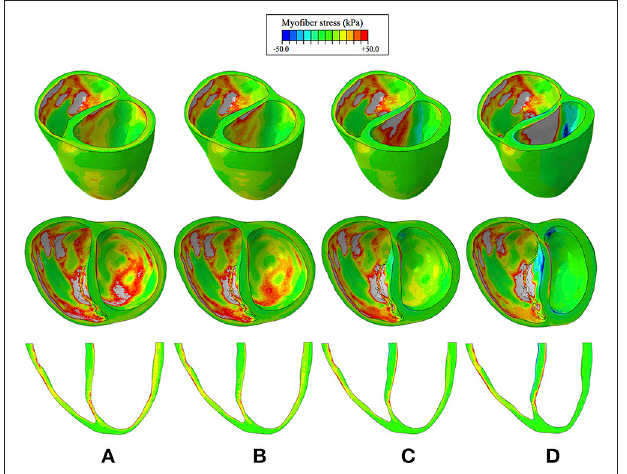
FIGURE 8 | Interpolated histograms of myofiber stress distributions in the region of maximum septal shift (colored region of inlaid illustration) for all simulations of CHF and LVAD operation. Mean ± SD values are given in the legend for each case. Histograms are normalized by probability density (PD), i.e., the area under each distribution sums to 1.